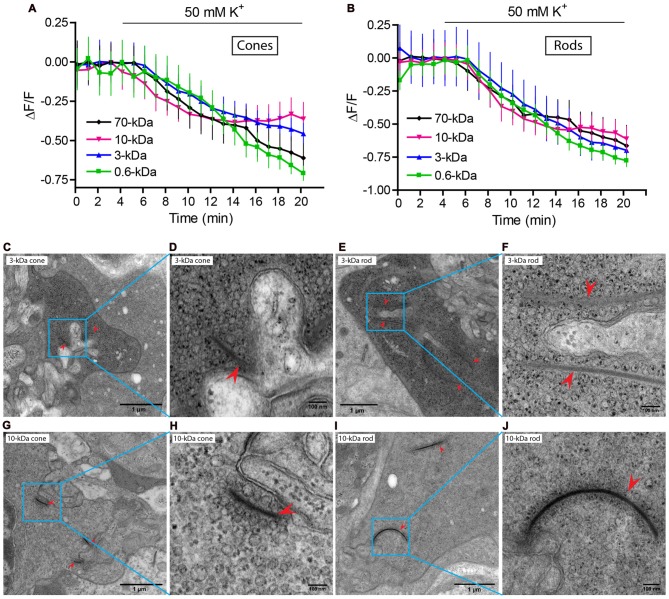
Dyes were loaded into synaptic vesicles. (A,B) Fluorescence (ΔF/F) of SR101, 3-, 10- and 70-kDa Texas Red declined upon application of 50 mM K+ in both cones (A) and rods (B). Slices were incubated with SR 101 (83 μM, 30 min), 3-kDa Texas Red (133 μM, 45 min), 10-kDa Texas Red (100 μM, 60 min), and 70-kDa Texas Red (36 μM, 60 min). Each experiment was repeated three times and each data point shows the average ± SEM from 8 to 44 terminals. The capability of dyes to be released from retinal slices by depolarizing stimulation indicates they were loaded into releasable synaptic vesicles. (C–J) Electron micrographs of photoreceptor terminals loaded with lysine-fixable, 3-kDa Texas Red (7 μM). After photoconversion in the presence of DAB, electron dense precipitate can be seen in vesicles throughout the terminals. A cone terminal with its characteristically small ribbons (arrowheads) is shown in (C) and a rod terminal with its larger ribbons (arrowheads) in (E). Panels (D,F) show magnified views of the square regions in (C,E), respectively. (G–J) Electron micrograph of a photoreceptor terminal loaded with 10-kDa Texas Red (7 μM). (G,I) show a cone and a rod terminal, respectively. (H,J) show magnified views of the square regions in (G,I).